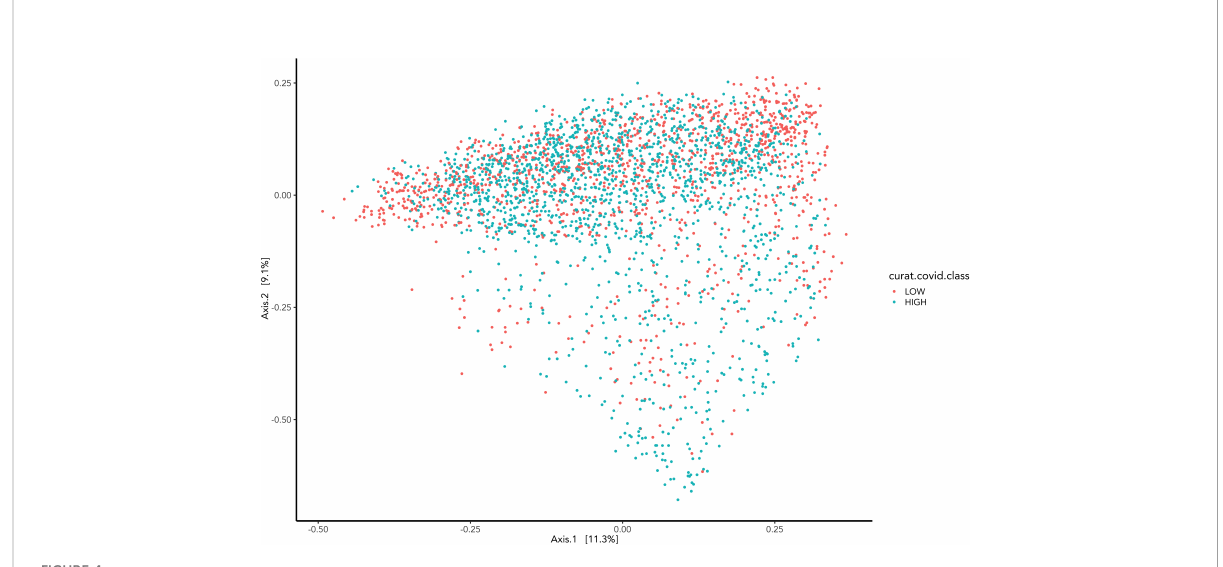
FIGURE 4 Represents the Bray-Curtis dissimilarity distance metric applied to PCoA graph representing the difference between samples grouped by COVID-19